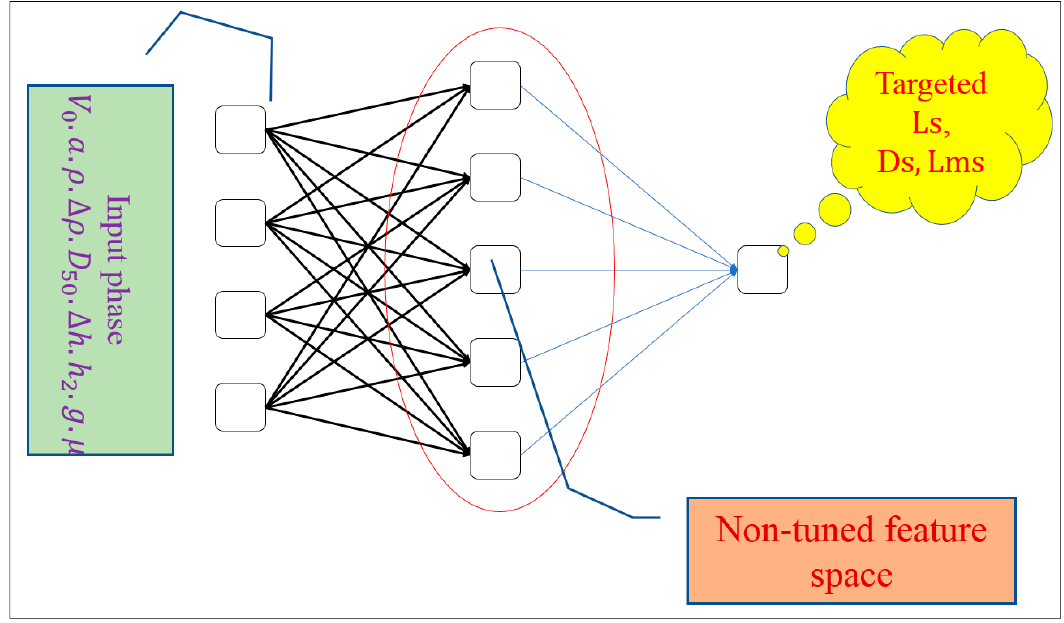
Figure 3. The structure of the extreme learning machine model used in the present study.